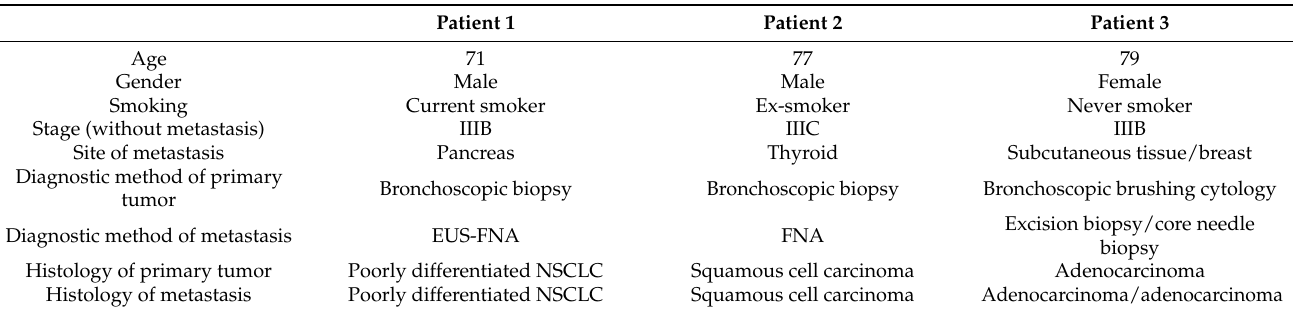
Table 1. Characteristics of three patients.